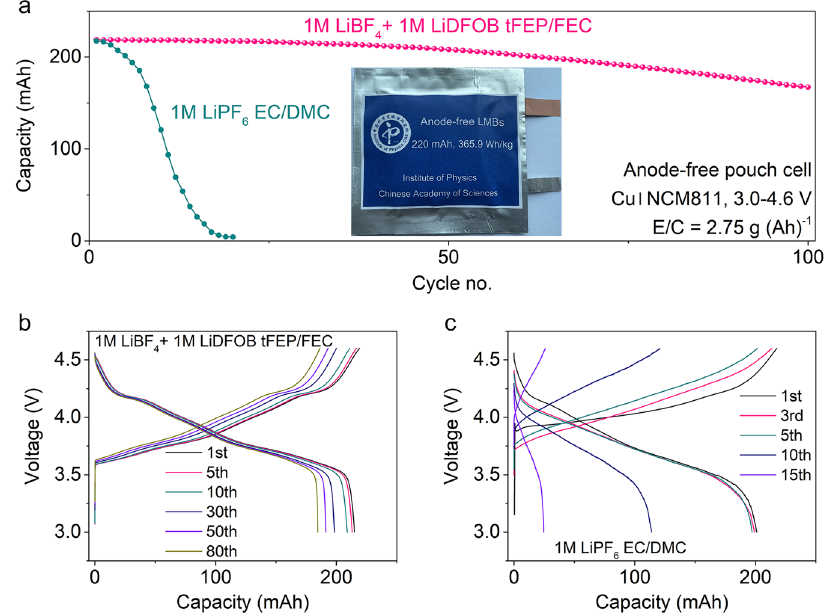
Fig. 6 | Electrochemical performance of anode-free Cu|NCM811 pouch cells. a Cycling performance and corresponding voltage pro fi les using b 1M LiBF 4 +1M